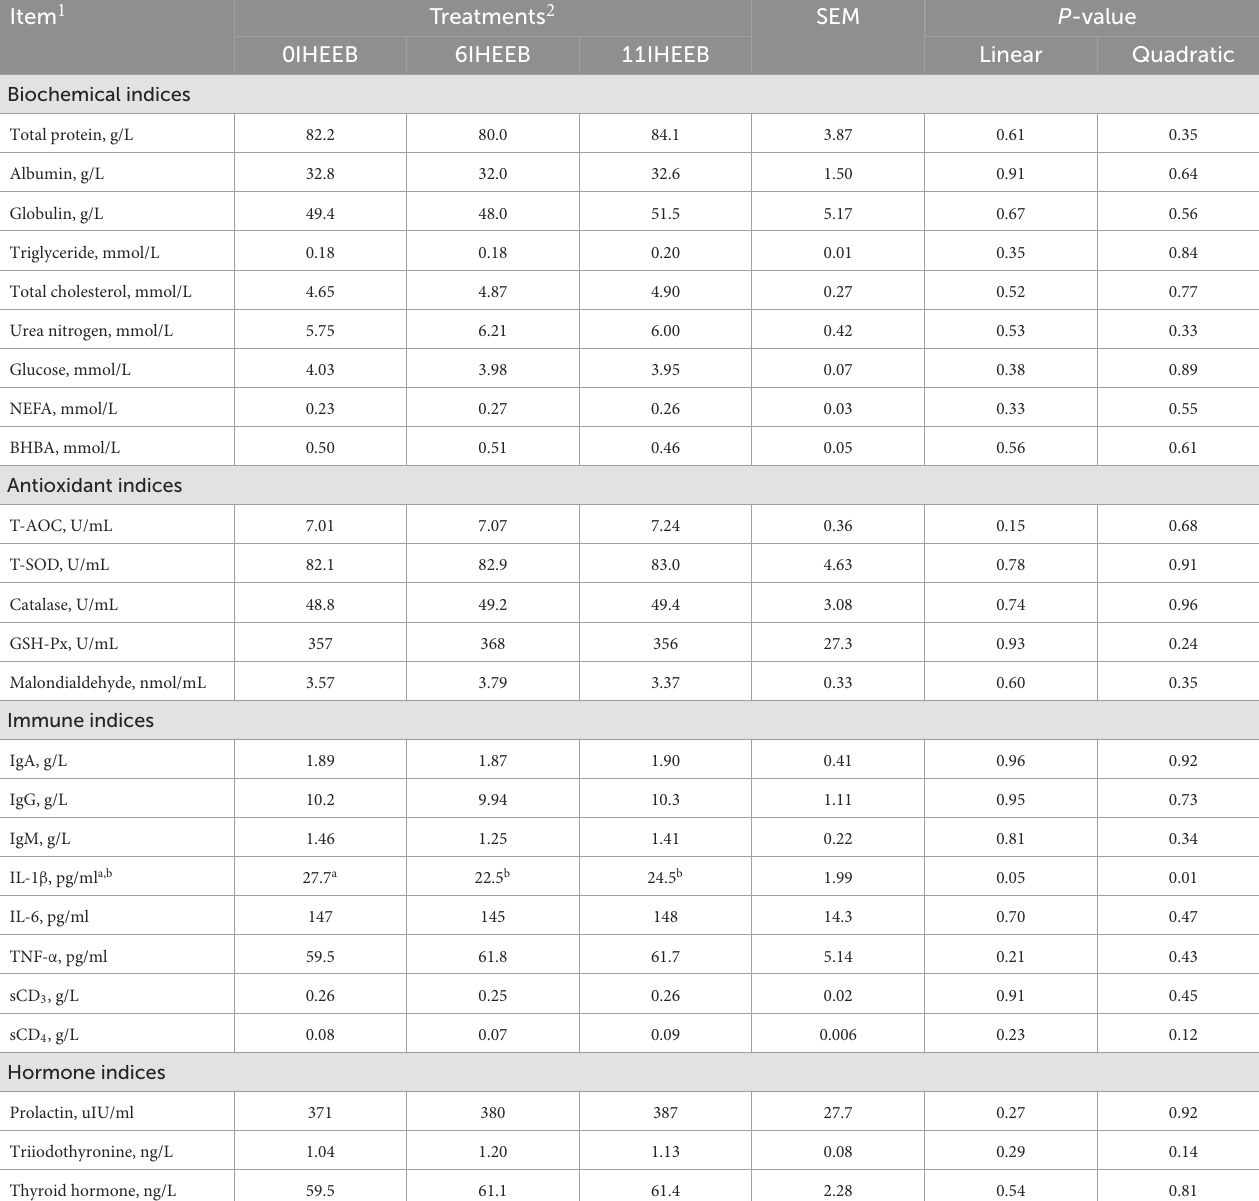
TABLE 6 Plasma metabolites in Holstein cows fed the 3